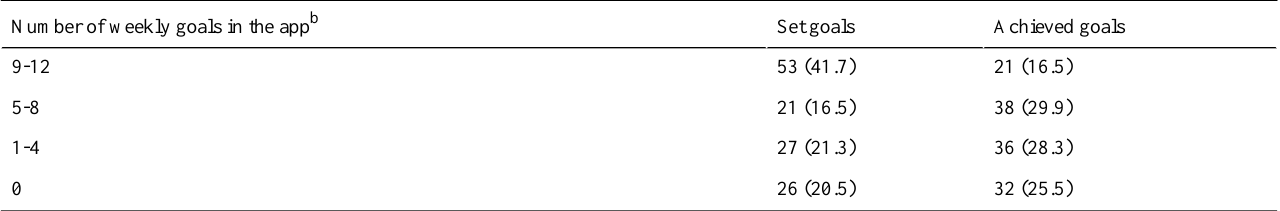
Table 4. Number of set and achieved goals in the TravelVu Plus app by the intervention group (n=127) during the 3-month intervention